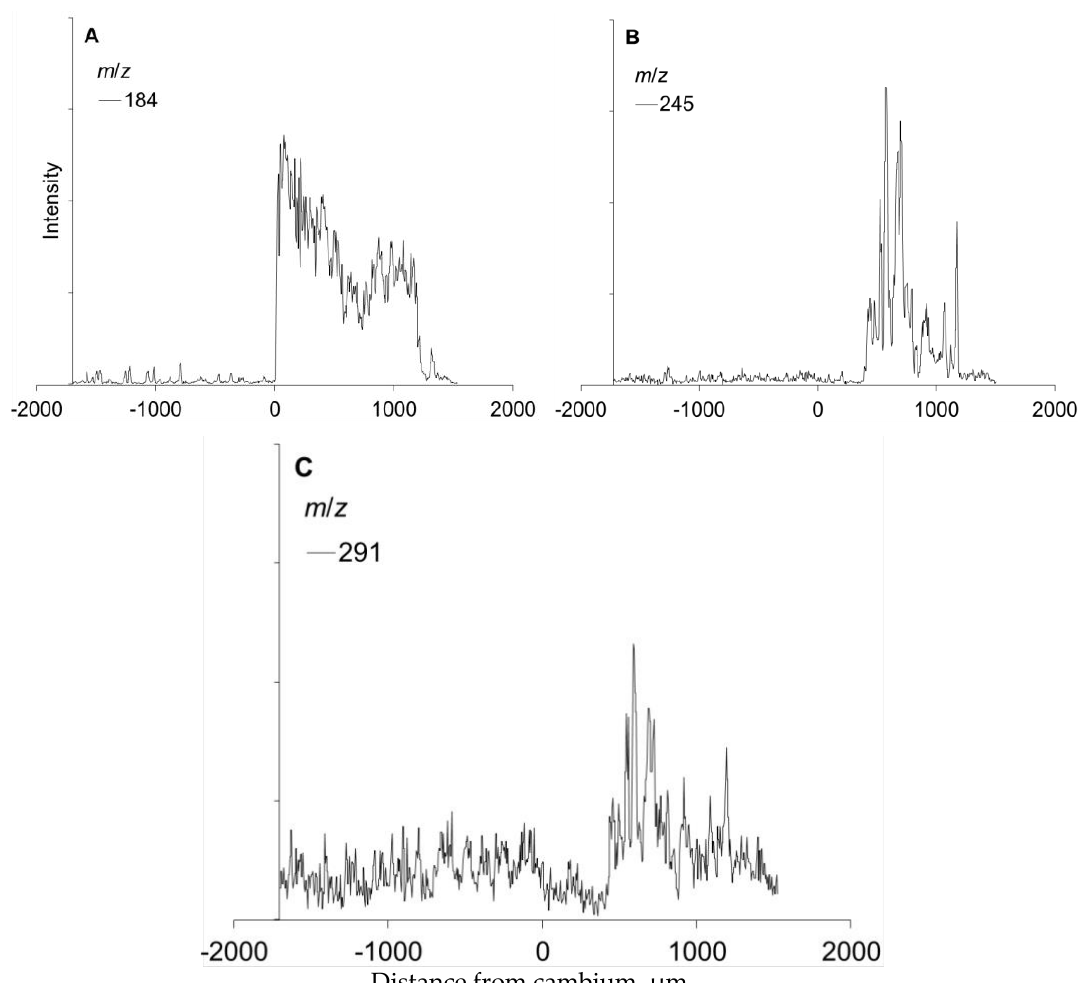
Figure 11. Ion intensities at m / z 184, 245, and 291 representing the membranes of living cells ( A ), stilbene glucoside astringin ( B ), and (+) − catechin, as detected by ToF-SIMS from the tangential-radial surface of frozen-hydrated Norway spruce phloem at different distance (µm) from the xylem to the cambium (the cambium location is 0 on the x-axis) and from the cambium to the outer bark of a wounded sapling. The ion counts are for the images shown in Figure 10 .